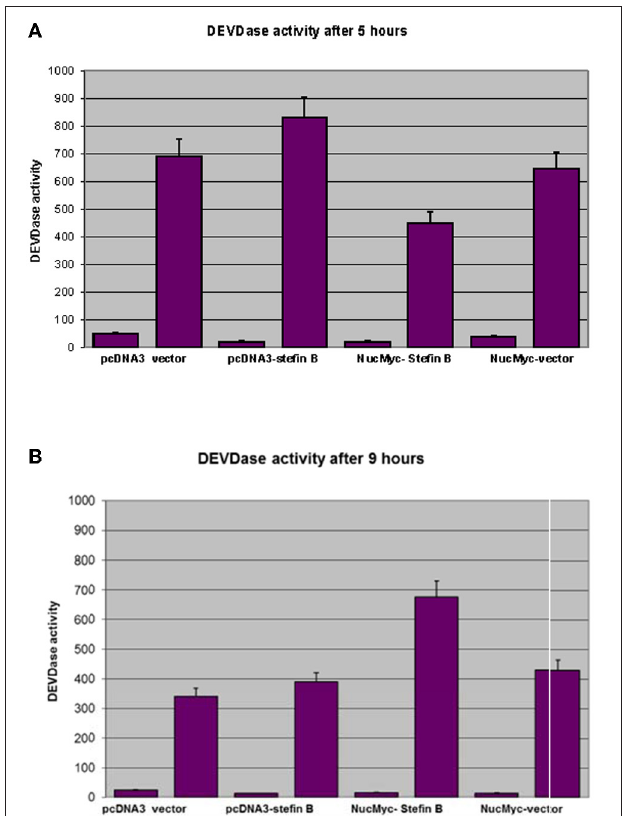
FIGURE 3 | DEVD-ase activities in the cell lysates. T98G cells transfected with an empty vector (pcDNA3 vector), T98G cells overexpressing stefin B in the cytosol (pcDNA3-stefin B) and in the nucleus (NucMyc-stefin B), together with a control empty vector pEF/myc/nuc (NucMyc-Vector) were treated with 500nM STS. DEVD-ase activities were determined after 5h (A) and 9h (B) of incubation, as described in Materials and Methods. Results are means ± S.D. of at least three independent experiments performed in